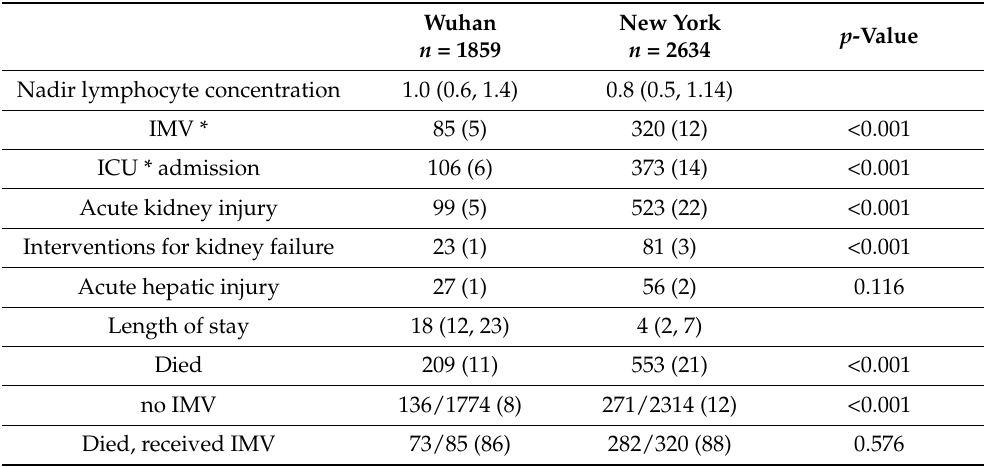
Table 2. Hospital course and